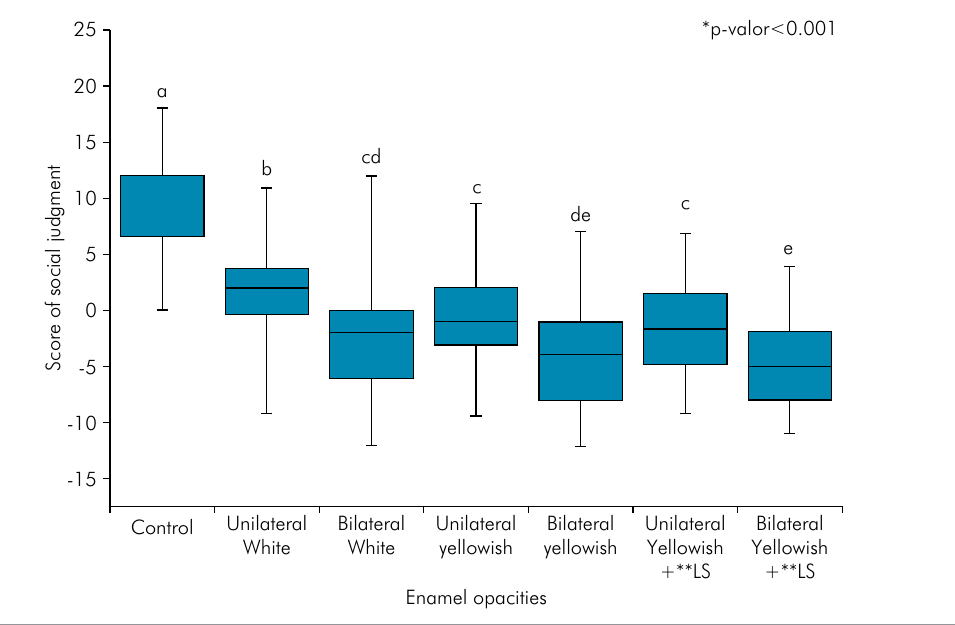
Figure 4. Beauty score according to enamel opacities. Rectangle height represents quartiles 1 and 3; the line that cuts the rectangle represents the median; the semi-quarters connect quartiles 1 and 3 to the minimum and maximum values. *Friedman test (different a, b, c, d, e, f letters in rows indicate the statistical difference in opacity change according to the Wilcoxon test); **Opacities with loss of structure.